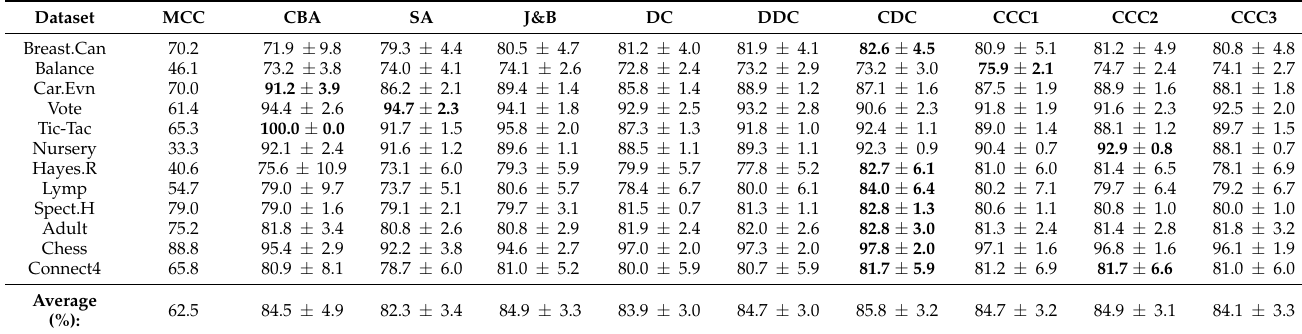
Table 2. Overall accuracies with standard deviations.